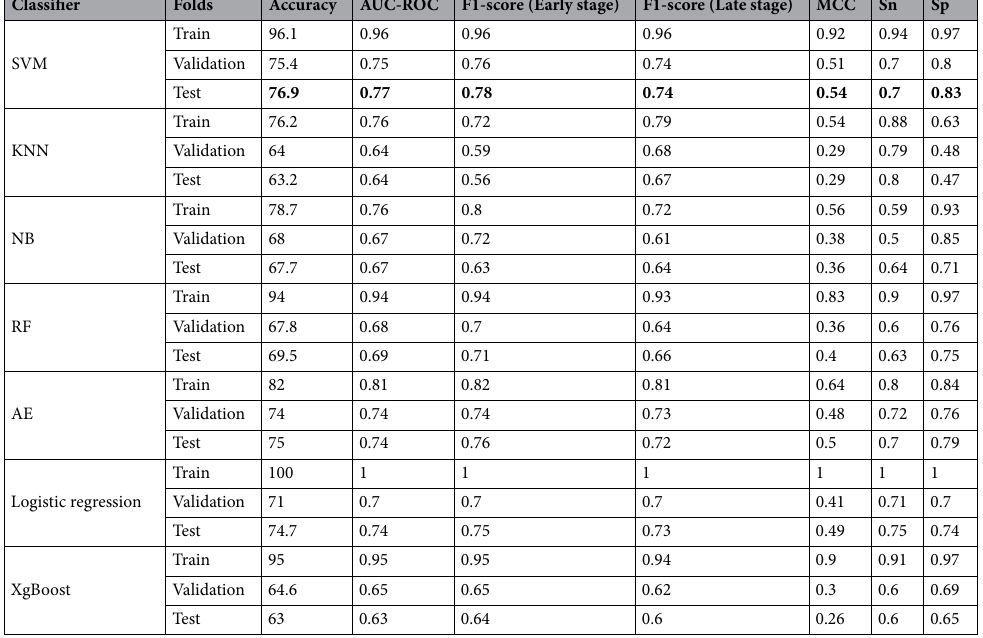
Table 3. The performance of classifiers based on 200 selected mRNAs and miRNAs. Significant values are in bold. AUC: The area under the curve, ROC: receiver operating characteristic curve, MCC: Matthews Correlation Coefficient, Sn: sensitivity, Sp: